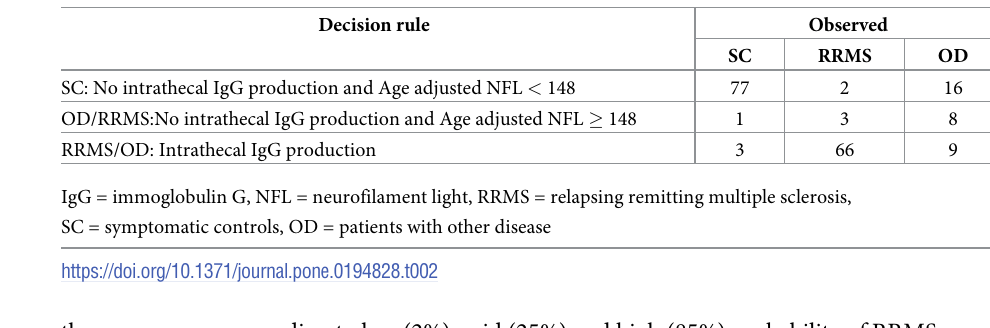
three scores corresponding to low (2%), mid (25%) and high (85%) probability of RRMS (Fig 4).